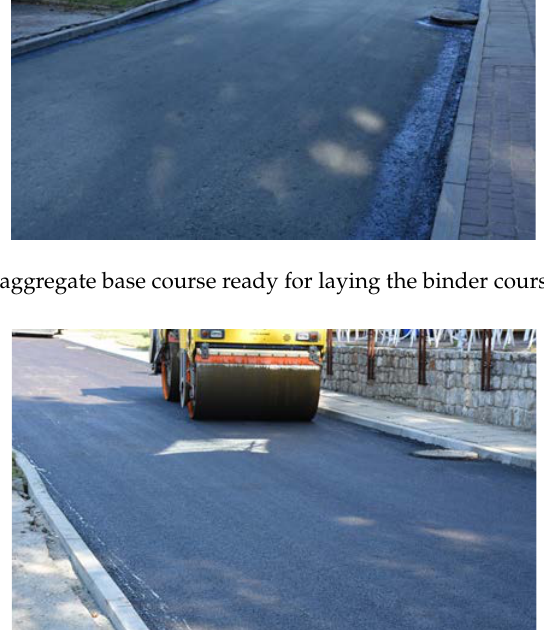
Figure 8. Compaction of the binder course AC 16W.